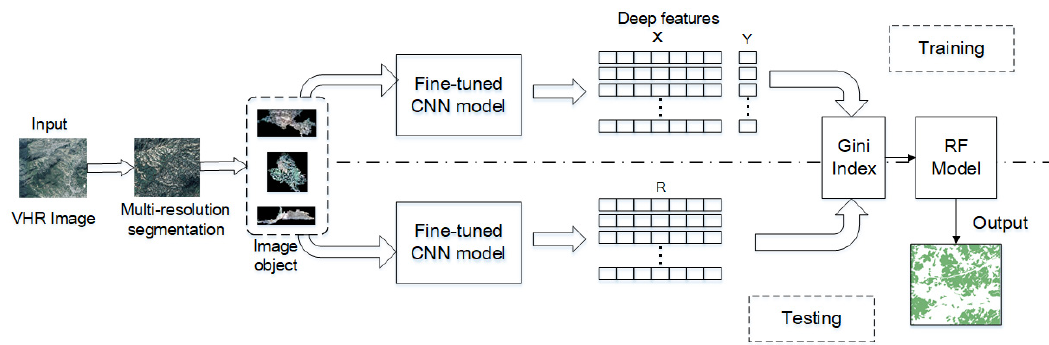
Figure 2. Workflow of the proposed extraction of tea plantations from very high resolution (VHR) remote sensing